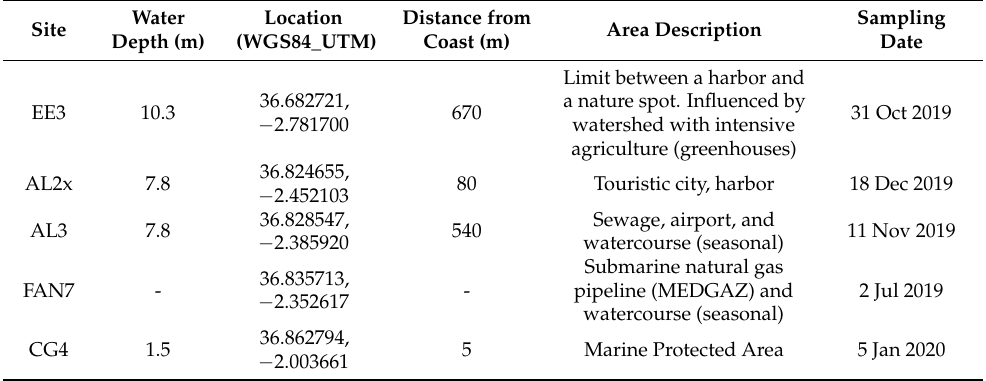
Figure 4. Study Area: ( A ) Map of the Mediterranean Sea Basin; the yellow square highlights Almeria coast, our study area. ( B ) Map of the coast of Almeria indicating the locations of the sampling stations. From west to east: EE3, AL2x, AL3, FAN7, and CG4. Coordinate System: WGS84, UTM. Table 5. Characteristics of the considered sampling points in Almeria (Spain).